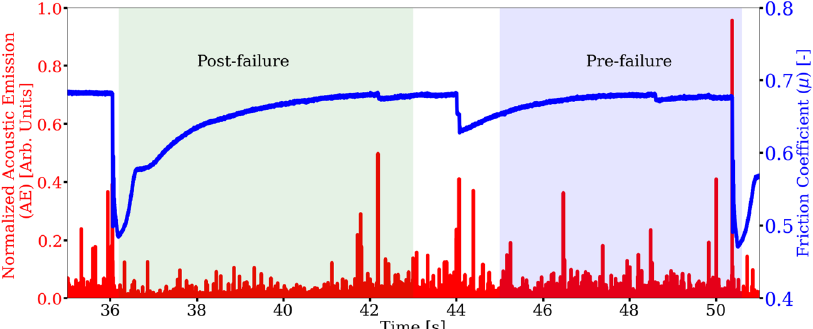
Fig. 8 Testing the limits of the transfer learning: convolutional encoder-decoder (CED) model with cross-training of the latent space applying limited portions of acoustic emission (AE) data from a single slip cycle. The model input signal is acoustic emission (AE in red, left axis), and the output signal is the friction coef fi cient ( μ in blue, right axis). The portion of the time series shaded light green shows the post-failure data used for the transfer learning exercise and shaded light blue shows the